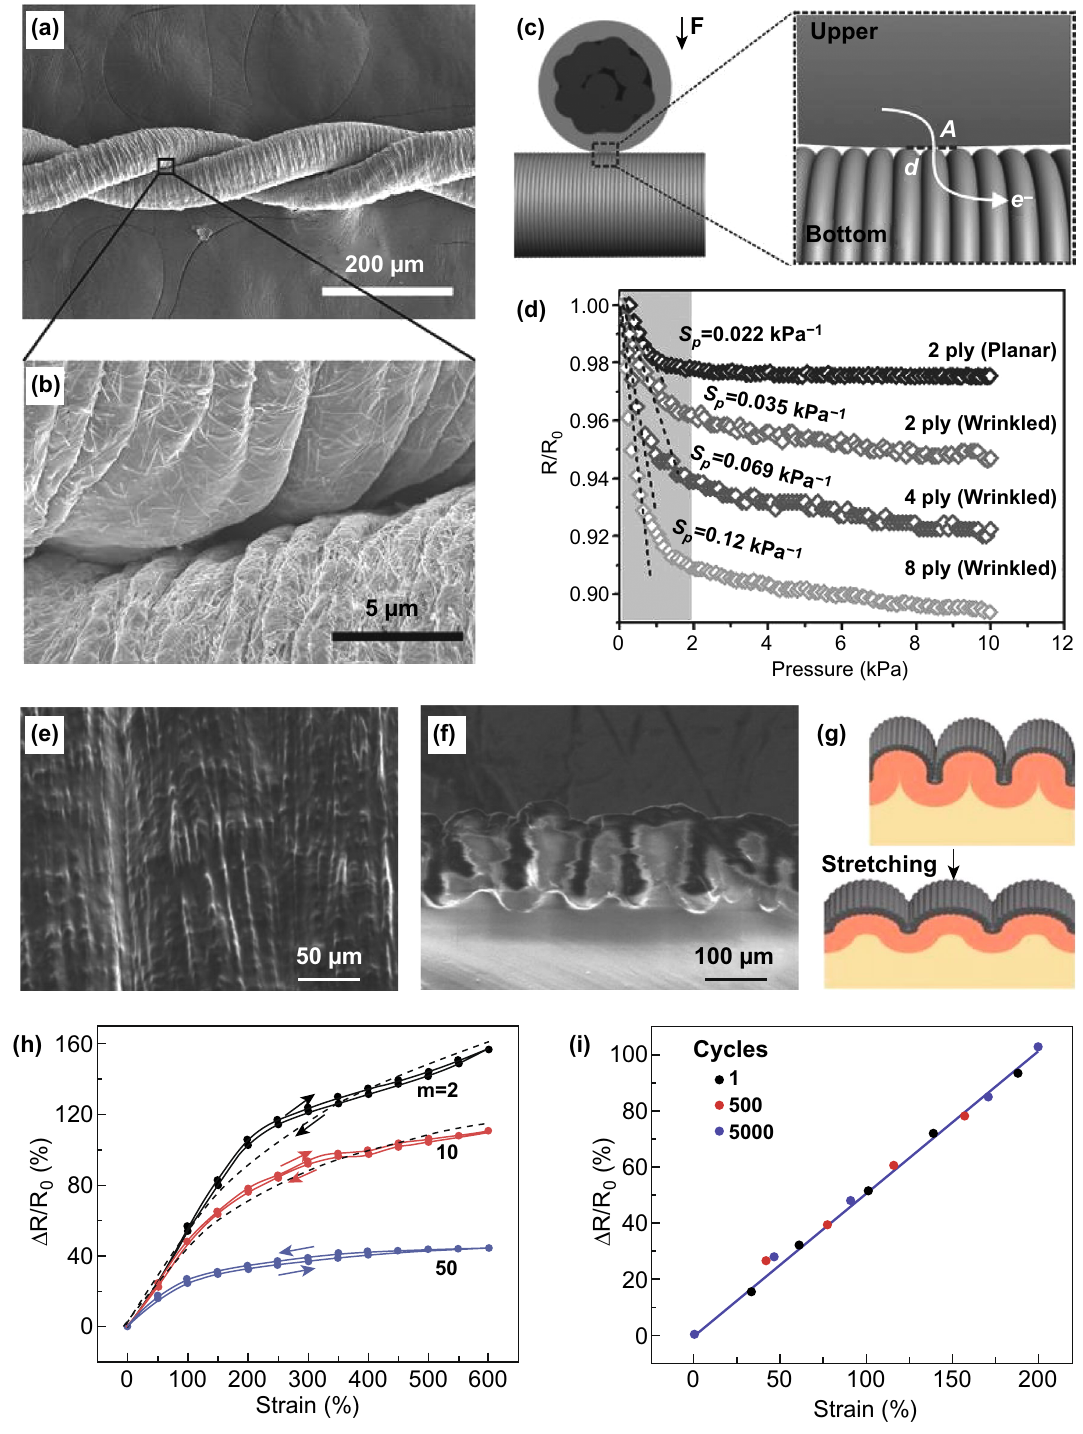
Fig. 15 Self-contact creases on elastic fibers for flexible electronics. a – d Twisted flexible piezoresistive fiber: a , b SEM images of 2 ply creased fibers. c Schematic diagram of the sensing mechanism. d Relative resistance change with the variation of pressure [191]. Copyright 2016 Wiley. e – i A bi-sheath fiber for strain sensors: e , f SEM images of CNT creases on superelastic fibers, g schematic illustration of the separation of self- contact creases by external strain, h the resistance of the creased CNT shells decreases with reducing the contact area between neighboring CNT creases by applying strain, i stability evaluation of the bi-sheath fiber sensor [60]. Copyright 2017